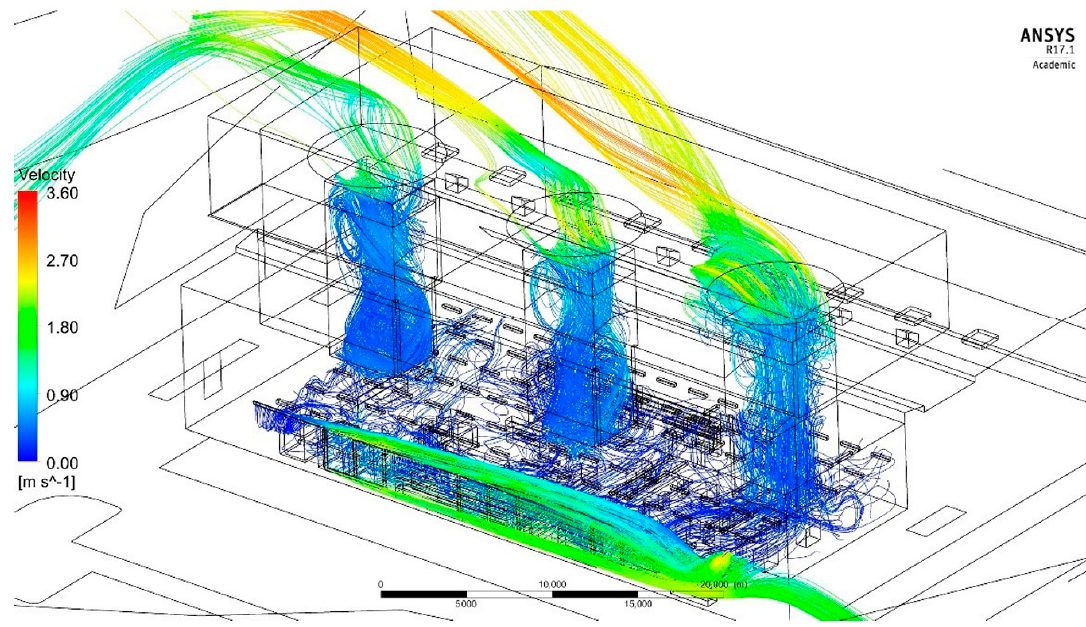
Figure 16. Airflow characteristic in the production hall with three updraft ventilation towers, velocity pathlines (m/s)—validated CFD model of the implemented Hungarian reference building (Supplementary Materials).